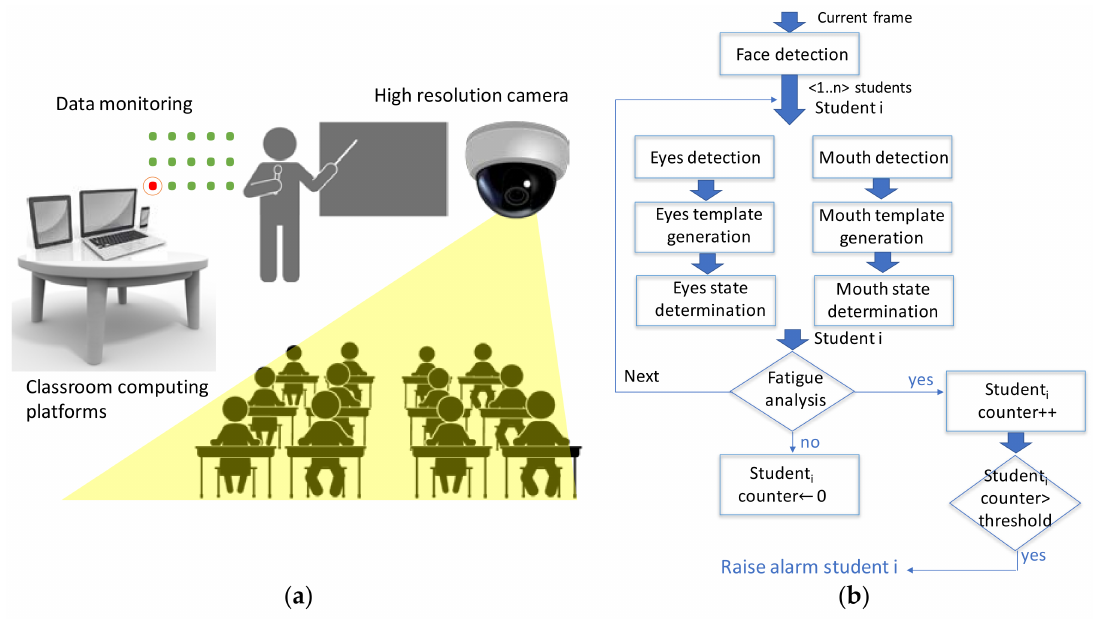
Table 2. Time estimation of fatigue analysis application.